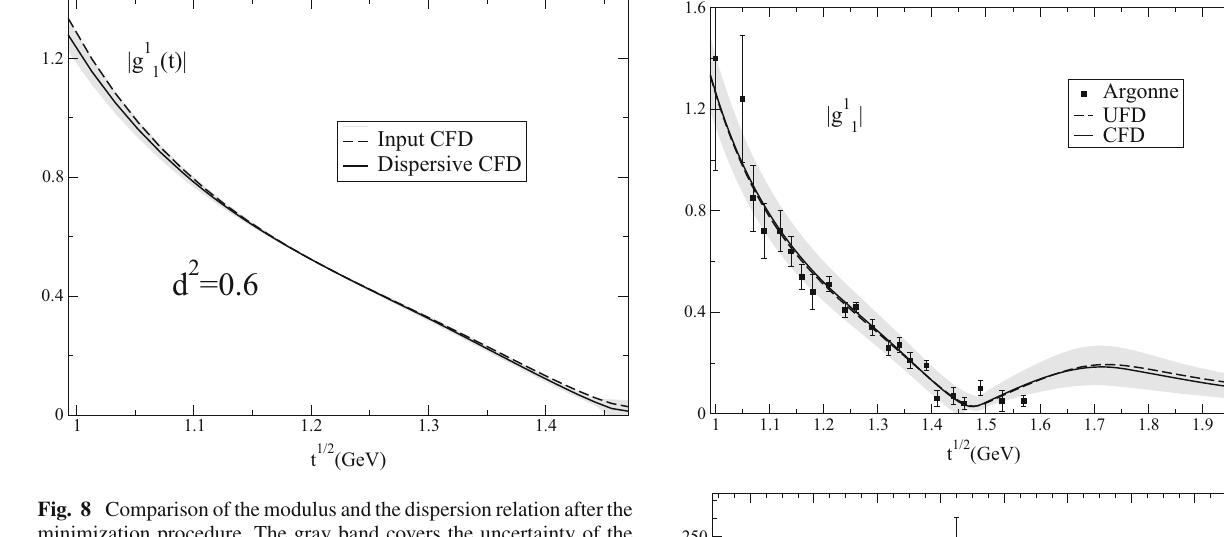
Fig. 8 Comparison of the modulus and the dispersion relation after the minimization procedure. The gray band covers the uncertainty of the difference between the input and dispersive results